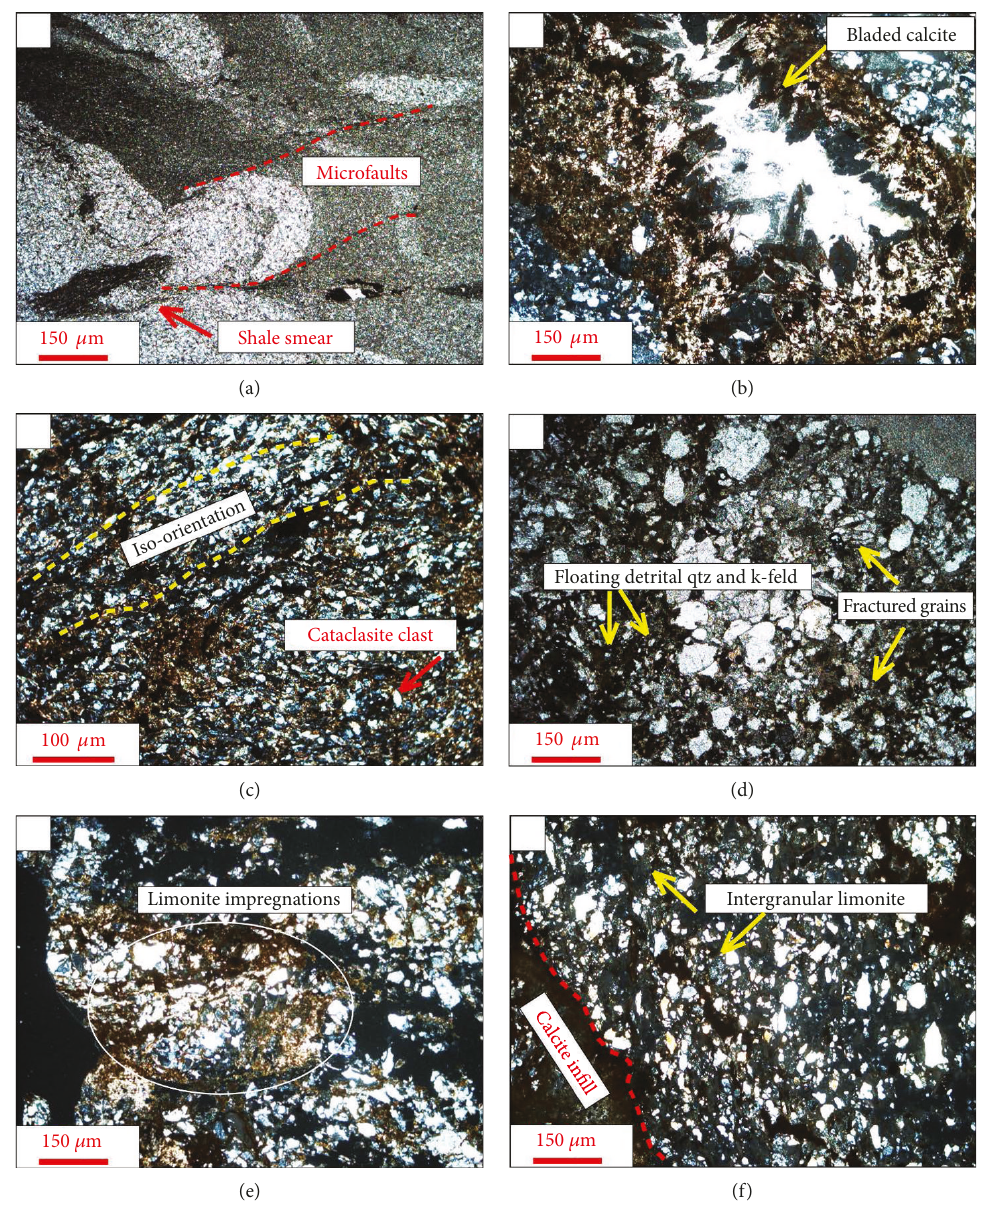
Figure 10: Thin sections cut from samples of fault core. (a) The darker parts are dominated by mica fl akes and clay. Mica fl akes have a tendency to iso-orientation and evidencing plastic fl ow within the lighter parts, which are made mainly of quartz and feldspar crystals and/or grains; (b) interstitial limonite between breccia clasts is rust red to dark brown (mottled color changes) and includes rare host rock-derived grains and patches of later calcite crystals in the middle of breccia clast interspaces; (c) cataclasite grains are barely distinguishable, both grains and crystals are fi ne sand to silt in size, and the interstitial spaces are fi lled by limonite that also coats/impregnates some grains and crystals; (d) interstitial sandstone is made of relatively loosely packed grains (detrital quartz and minor detrital feldspar, rock fragments, and mica) with more intergranular brownish to rust red limonite (also coating/impregnating some grains) than sandstone clasts; (e) fractured grains found in both clasts and matrix of the cataclasite; (f) grains iso-oriented parallel to the fault and with intergranular limonite are recognizable in the probable cataclasite (Figure 11). In this graph, pervious rock samples, character- ized by a higher porosity, wider pores (lower speci fi c surface area), and better connectivity (lower Euler characteristic), are localized to the upper left area. Rock samples located to the right of the graph tend to have a poorly connected pore net- work (more impervious).